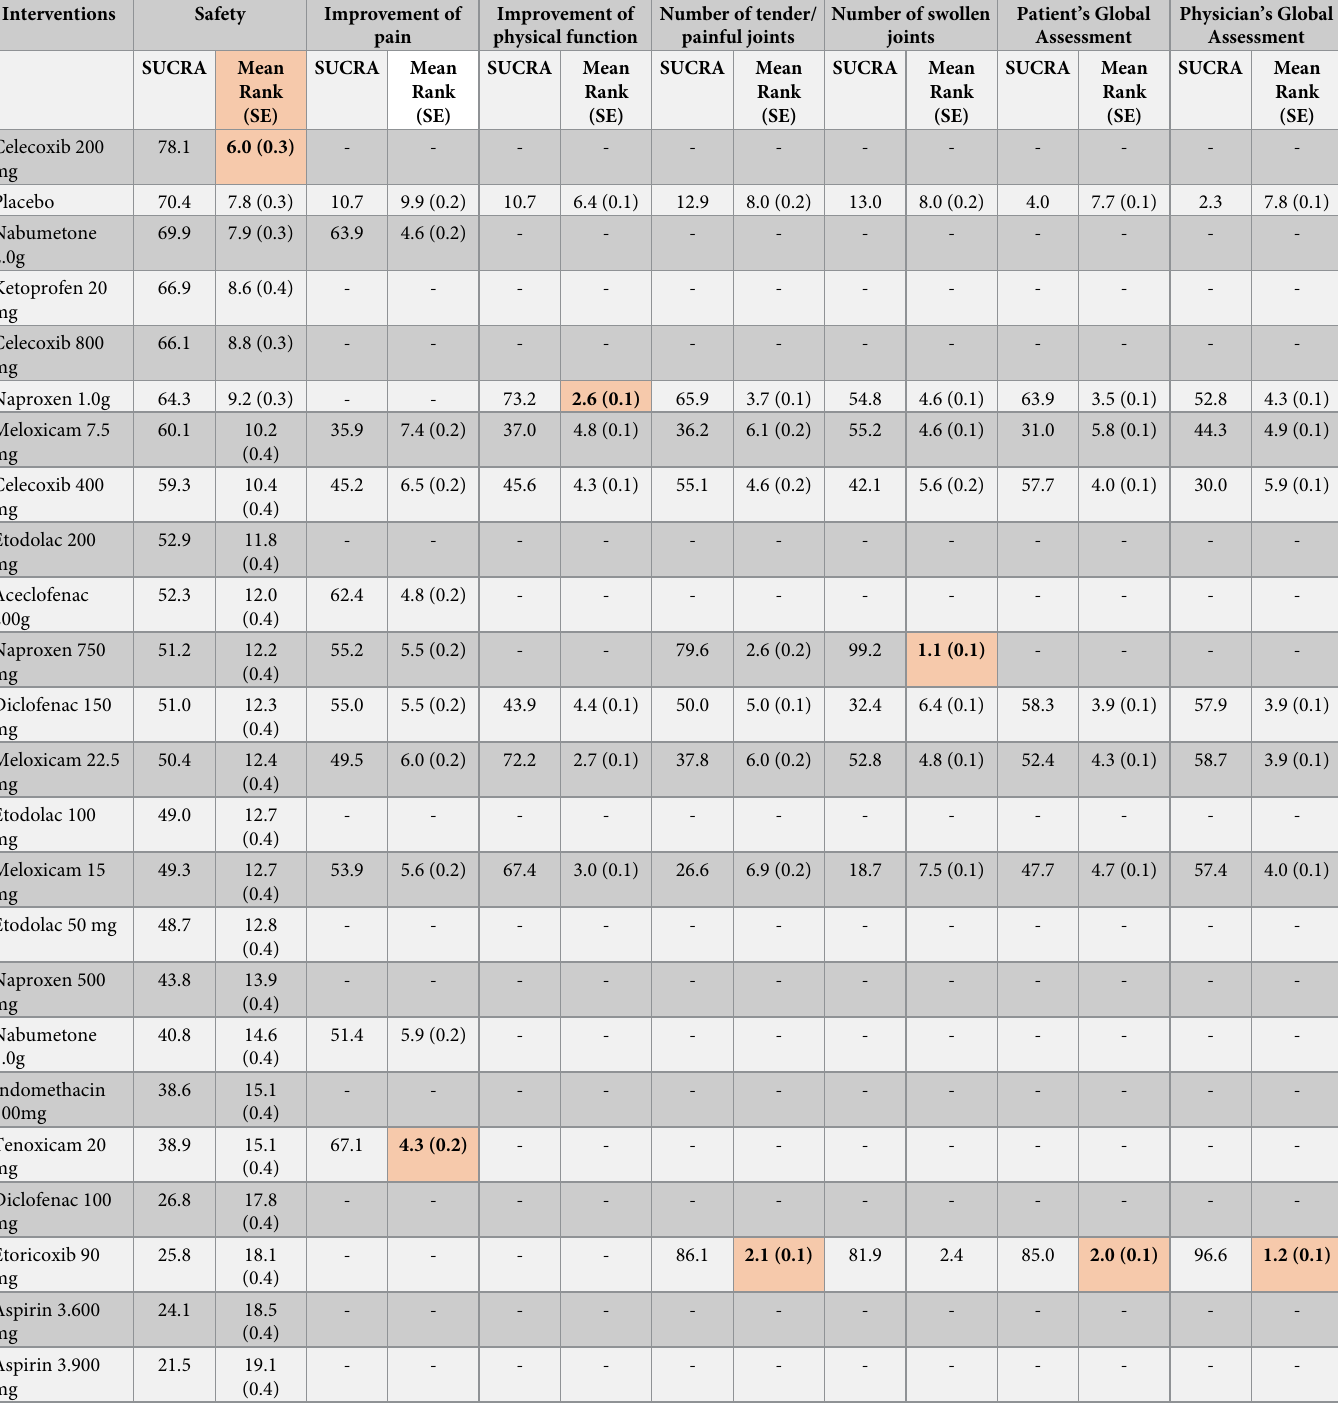
Table 2. Ranking of treatments for the outcomes assessed. Bold numbers on highlighted background are first in ranking. For the safety outcome, the highlight repre- sents the safety. For effectiveness outcomes, the highlight represents the most effective.